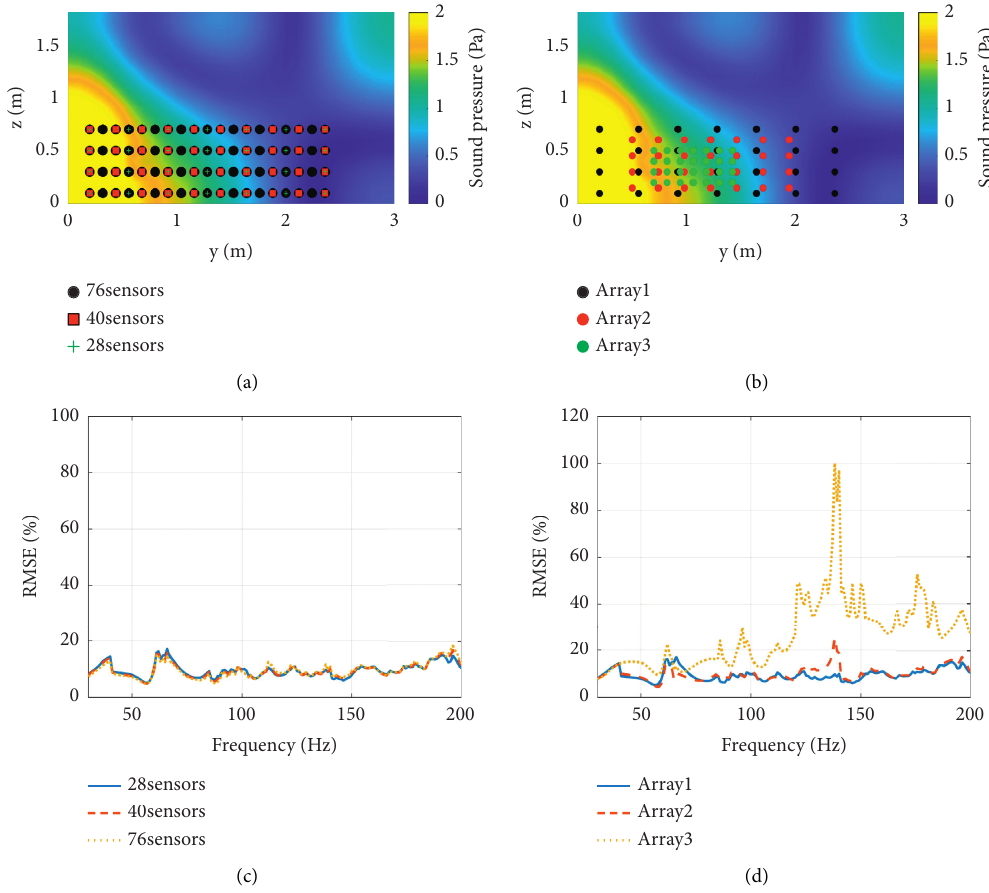
Figure 6: Analyses on the influences of sampling factors on performance. (a) Sensor positions for three arrays with different sensor quantities. (b) Sensor positions for three arrays with different sizes of sampling areas. (c) RMSEs corresponding to different numbers of sensors. (d) RMSEs corresponding to three arrays with different sampling areas. The backgrounds in (a) and (b) are the real sound fields of ( x ) � 3m at